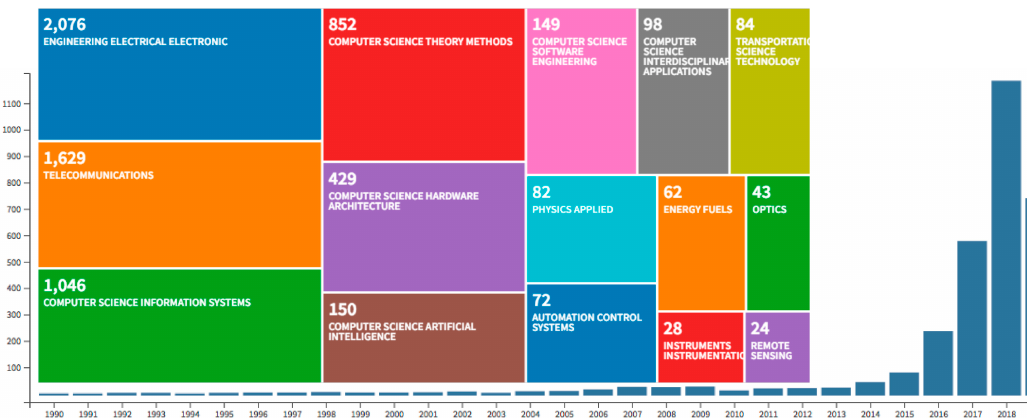
Figure 1. Article statistics showing the histogram of edge computing over publication years, a compilation from [54]. Inset: distribution by discipline [54]. Notable are the intensified research, the multidisciplinary character of the field, and the largest contributing disciplines. The number of other contributing disciplines (not shown) is also increasing rapidly.